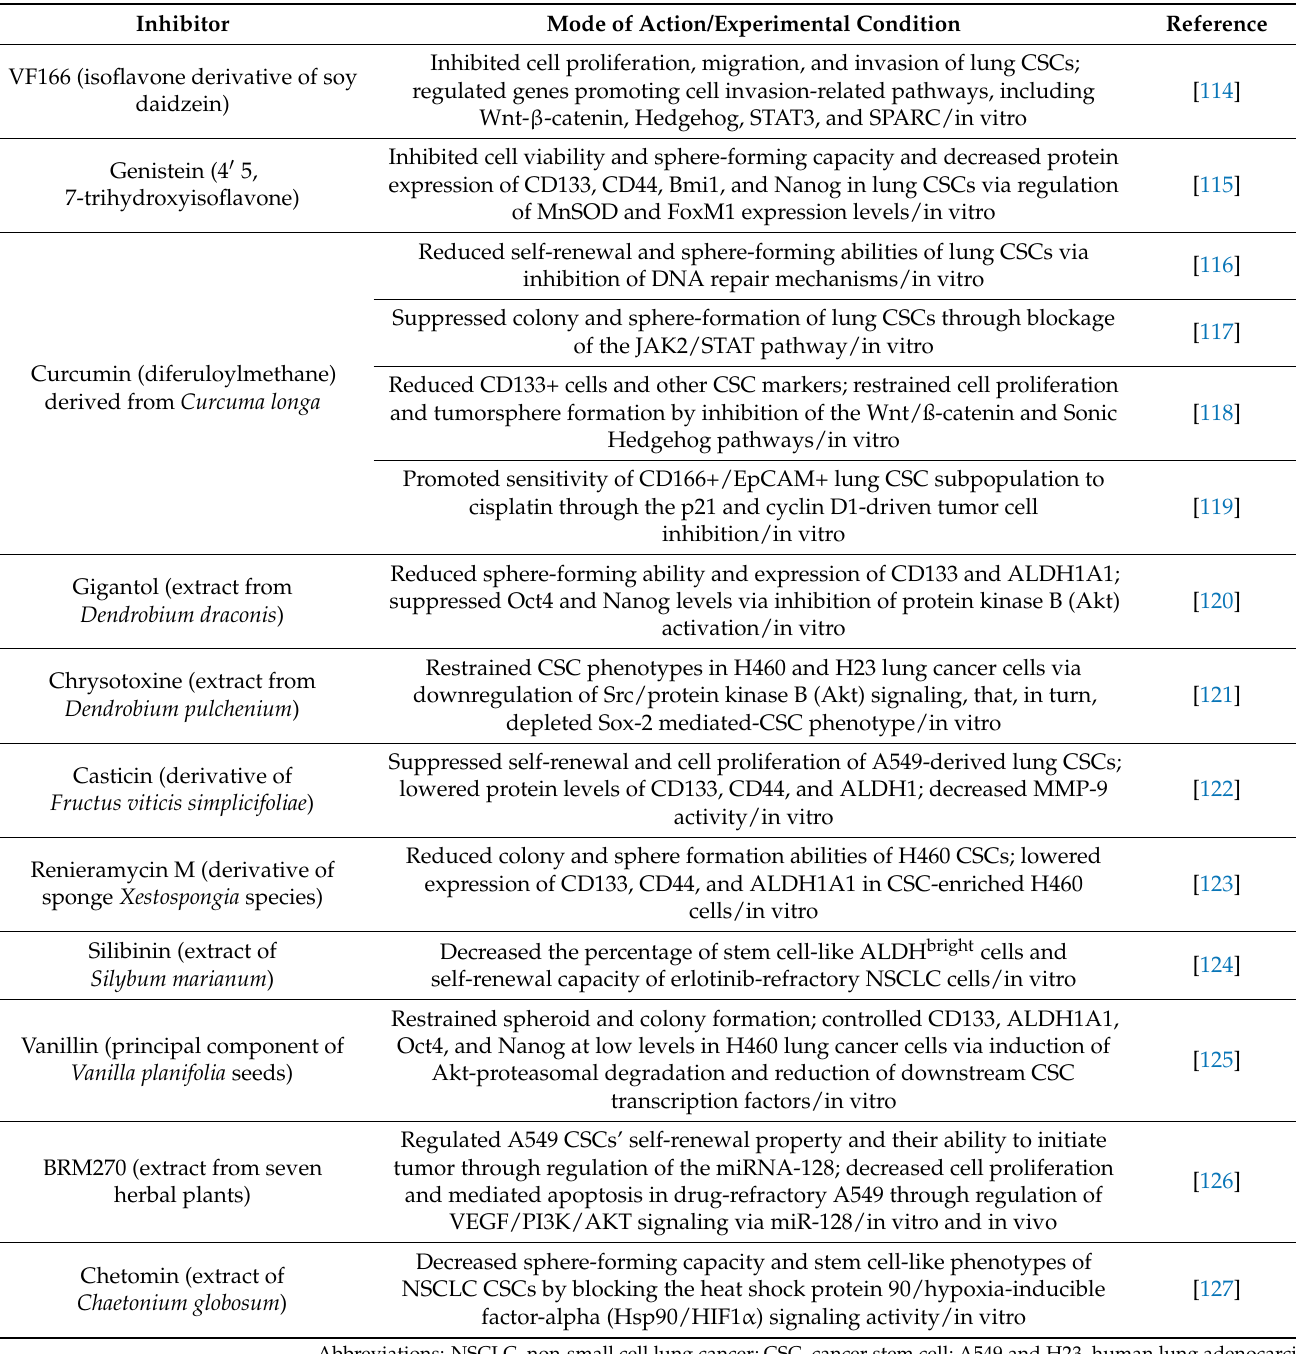
Table 2. Natural compound-based CSC inhibitors in lung